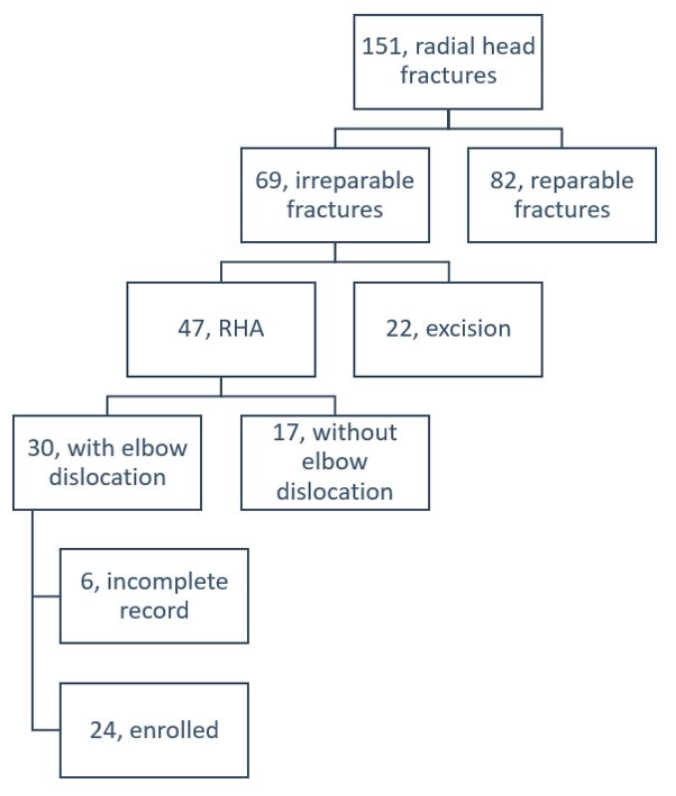
Figure 1. Patient number and surgical profiles in radial head arthroplasty (RHA). Based on retrospective chart review, 30 out of the 47 fractures in an equal number of patients receiving RHA exhibited concomitant elbow dislocation and were reviewed for